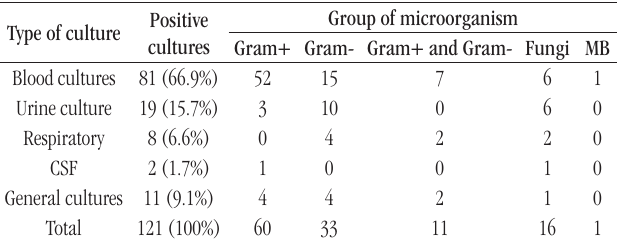
taBLE 2 − Patient classification by type of culture and main group of microorganism causing the infection